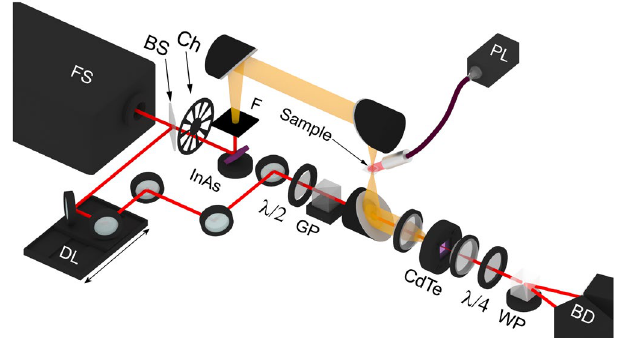
Figure 11. Schematic view of the THz time-domain spectroscopy setup working in transmission